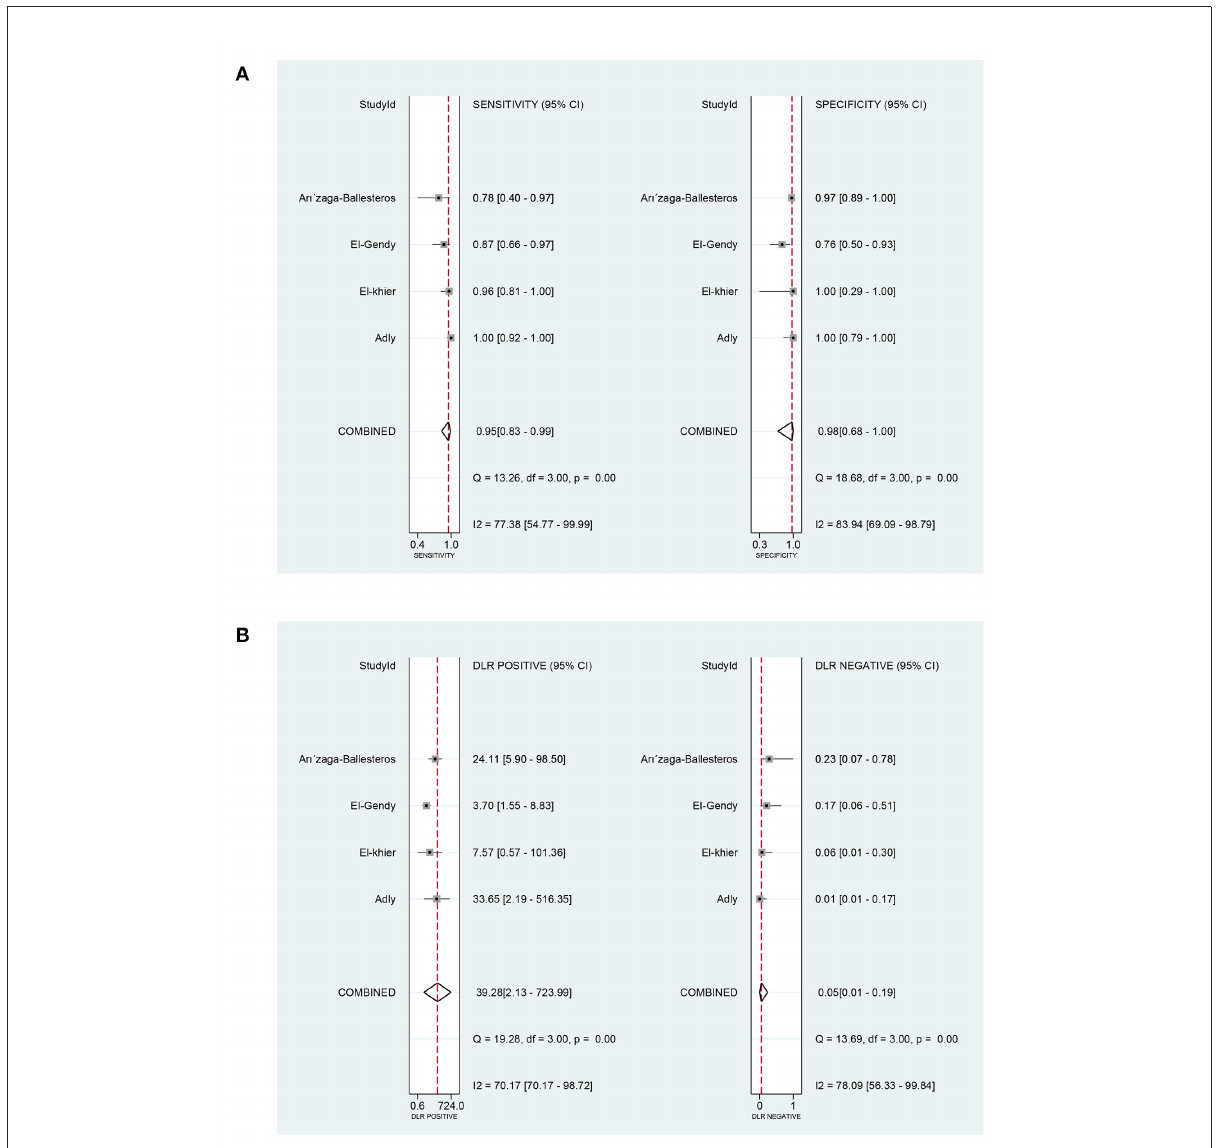
FIGURE8 The pooled sensitivity, specificity, PLR, and NLR of the prognostic value of sTREM-1 in neonatal sepsis. (A) The pooled sensitivity and specificity. (B) The pooled PLR and NLR. PLR, positive likelihood ratio; NLR, negative likelihood ratio; sTREM-1, soluble triggering receptor expressed on myeloid